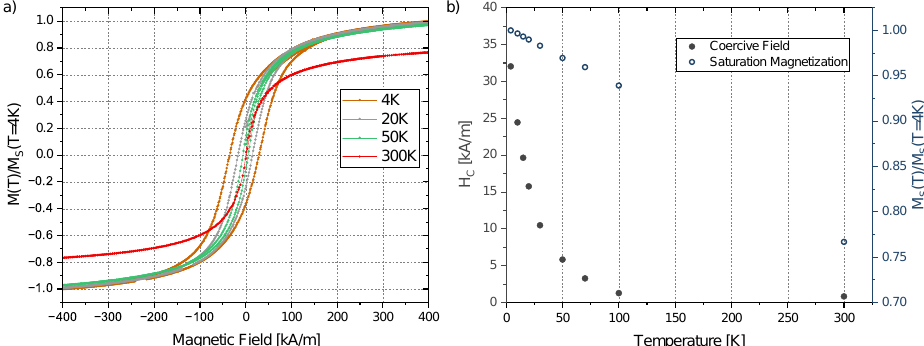
Figure 7. Temperature dependence of the magnetization for a sample irradiated with 200kGy. ( a ) Magnetic moment depending on the applied magnetic field for temperatures down to 4K and ( b ) coercive field (full points) and saturation magnetization (empty points) for temperatures between 4K and